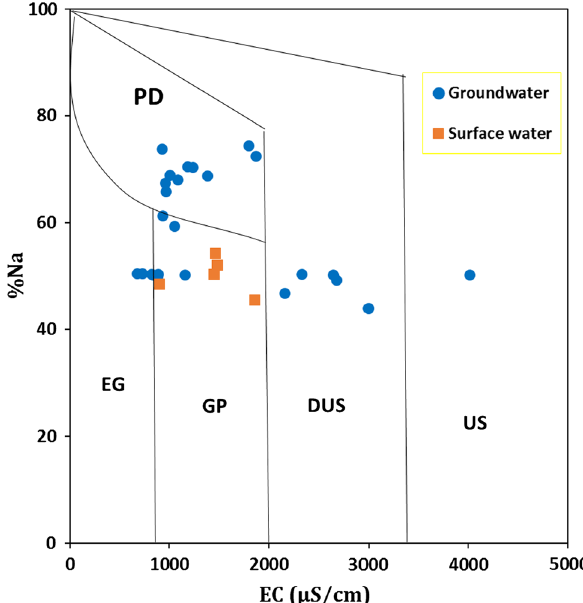
Fig. 18 Wilcox diagram for classification of water based on EC and %Na (EG—excellent to good, GP—good to permissible, DUS— doubtful to unsuitable, PD—permissible to doubtful, US—unsuit- able)